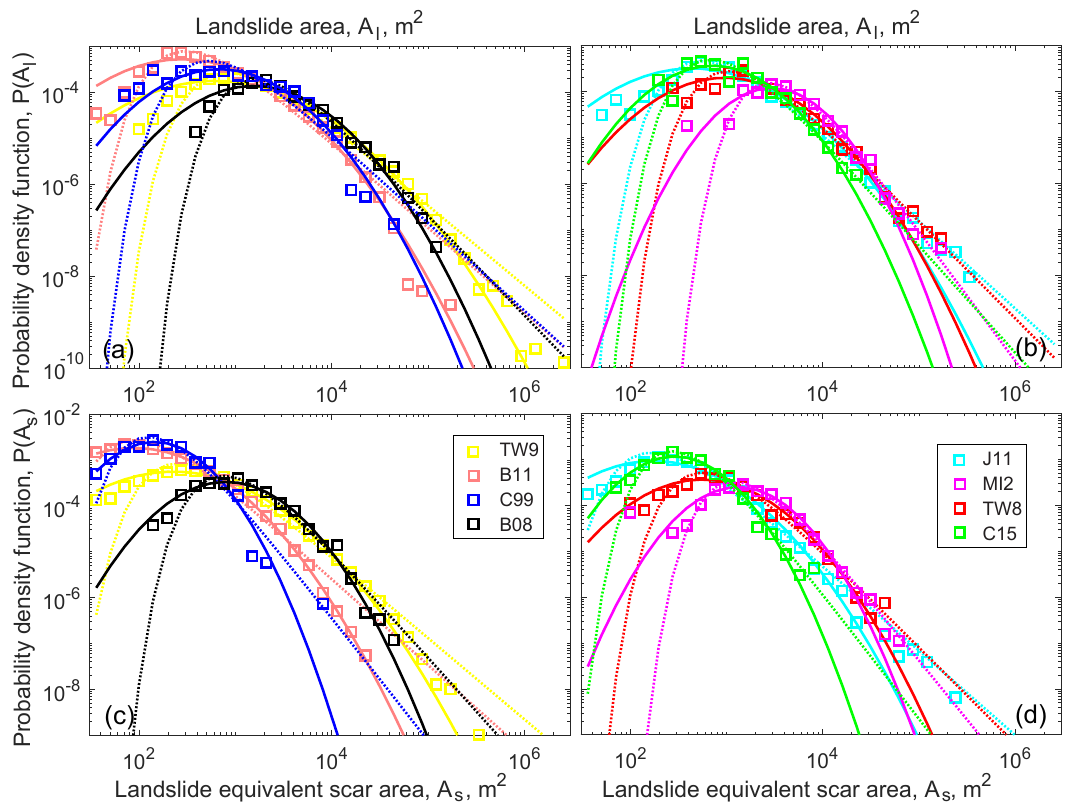
Figure 3. Probability density functions of landslide whole area (a, b) and estimated scar area (c, d) . To improve visualization we split the 8 inventories in two groups. A Log-Normal and Inverse Gamma Distribution maximum-likelihood estimation for the whole distribution are shown by solid and dashed lines,